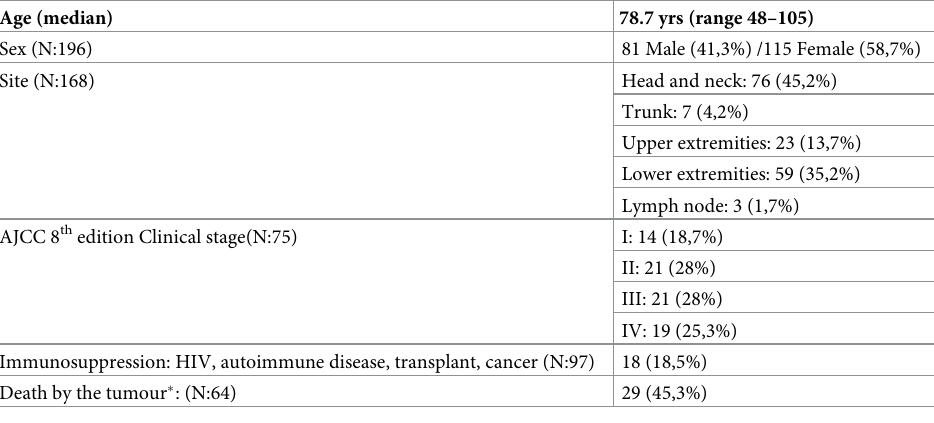
Table 1. Main clinical